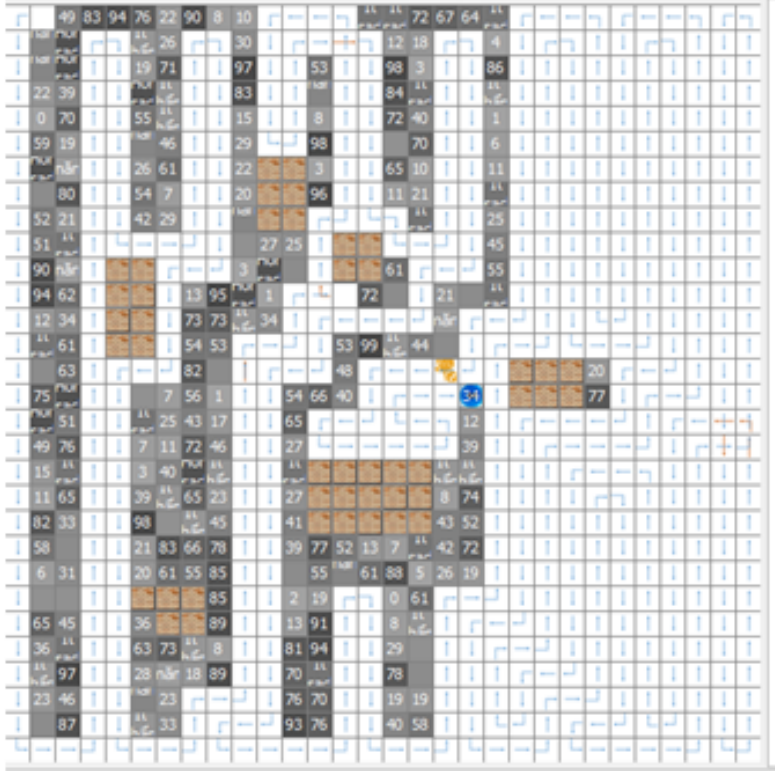
Figure 5. The Cleaning robot in operation using multiple decision